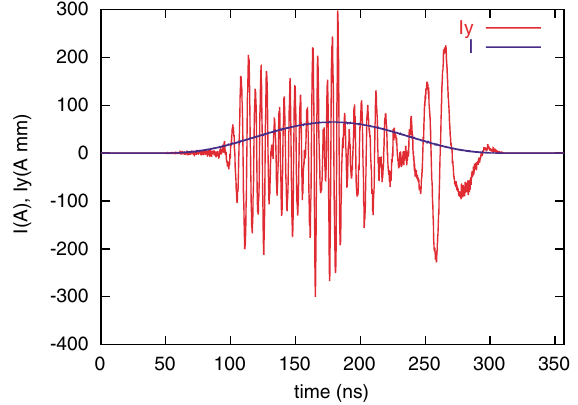
FIG. 20. (Color) Evolution of Y for PSR and SNS parameters in Table II.